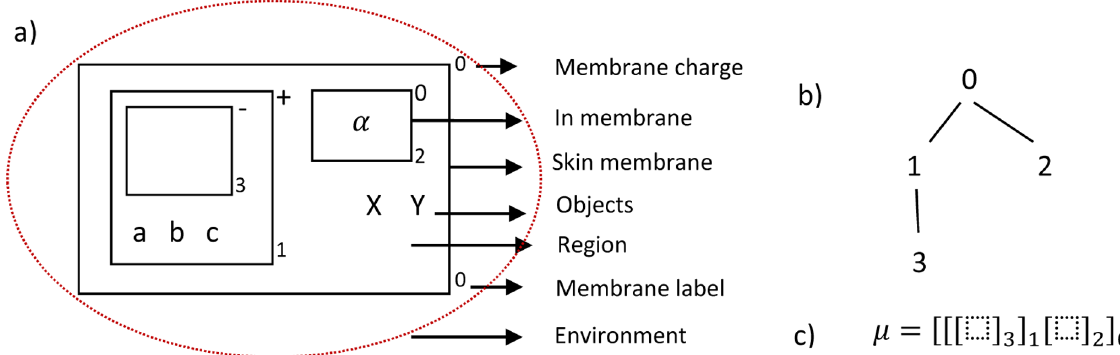
Figure 1. a) Representation and components of the cell, b) representation of the membrane structure using a rooted tree, and c) the analytical representation of membrane structure.